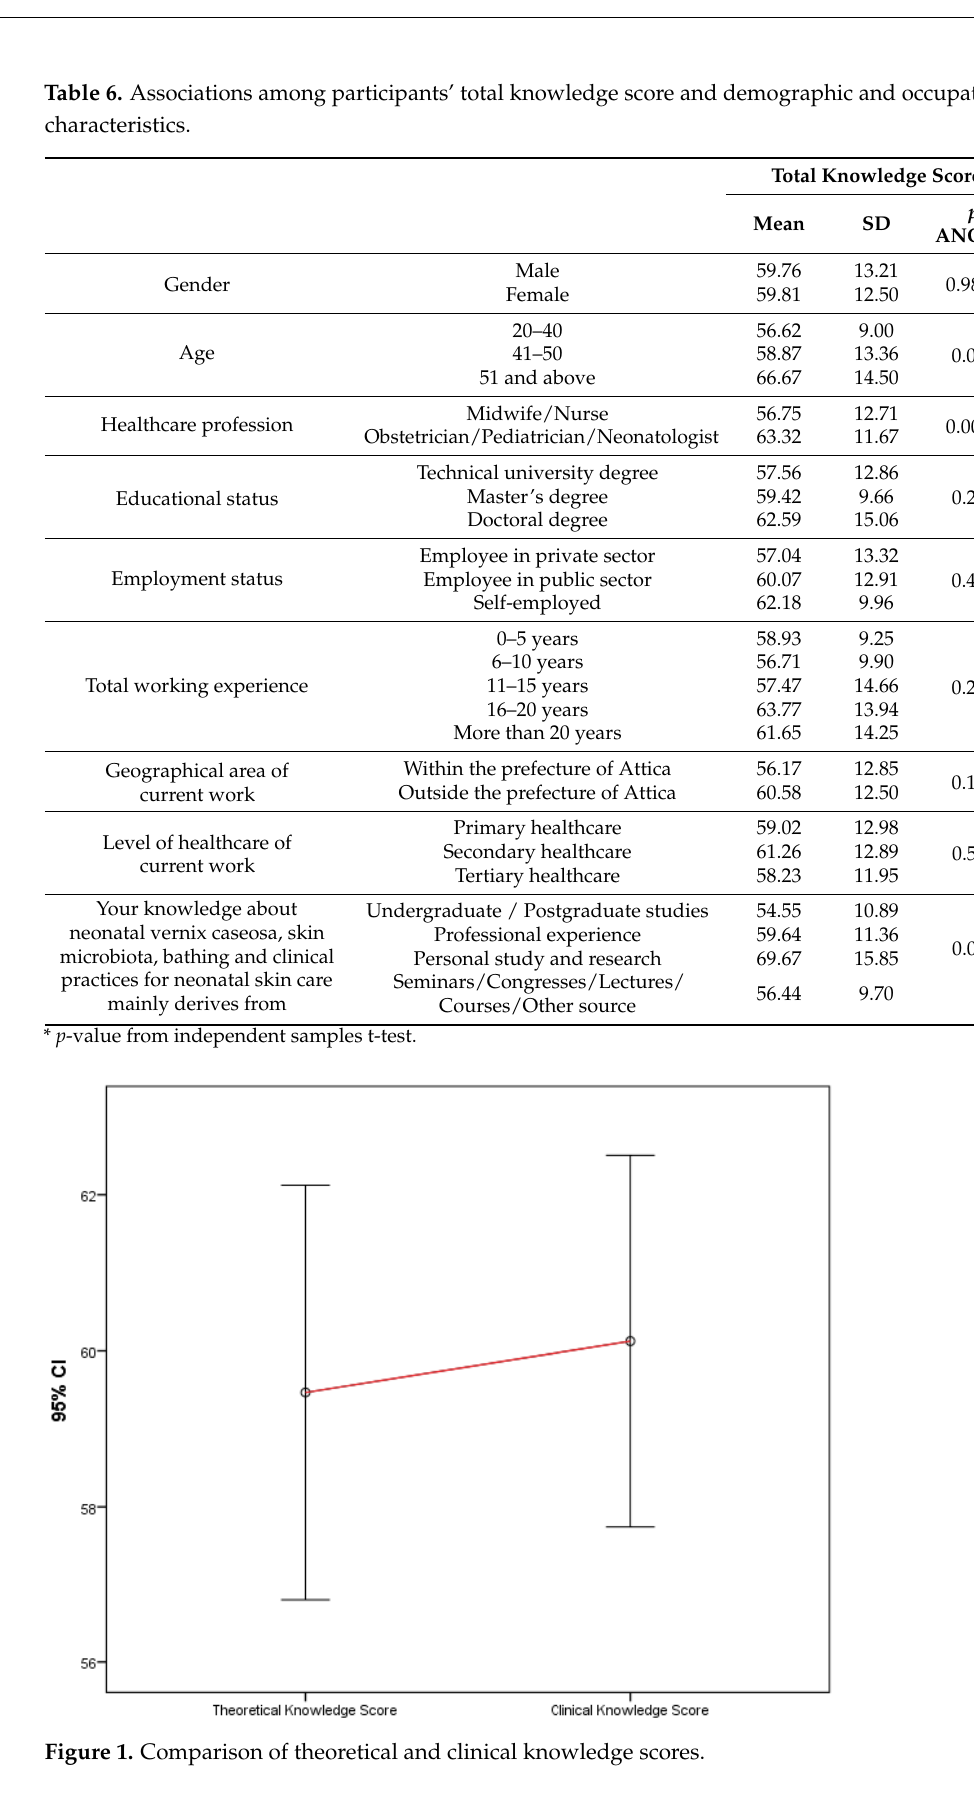
Clinical Knowledge Score Theoretical Knowledge